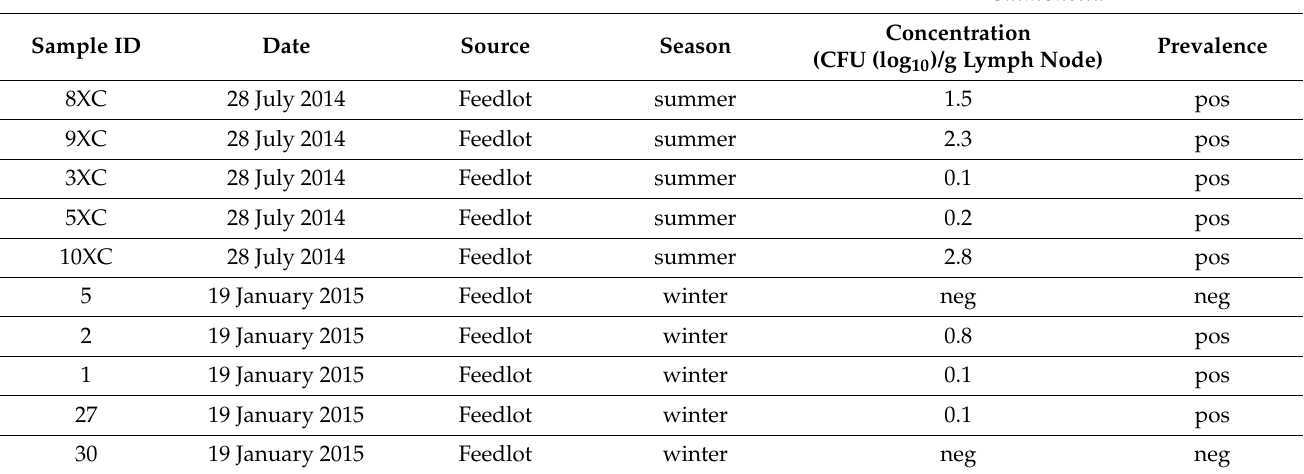
Table 7. Details of summer cattle that had either high or low concentrations of Salmonella in the sub-iliac lymph nodes, and winter cattle, that were positive or negative for Salmonella in the sub-iliac lymph node collected for kinome